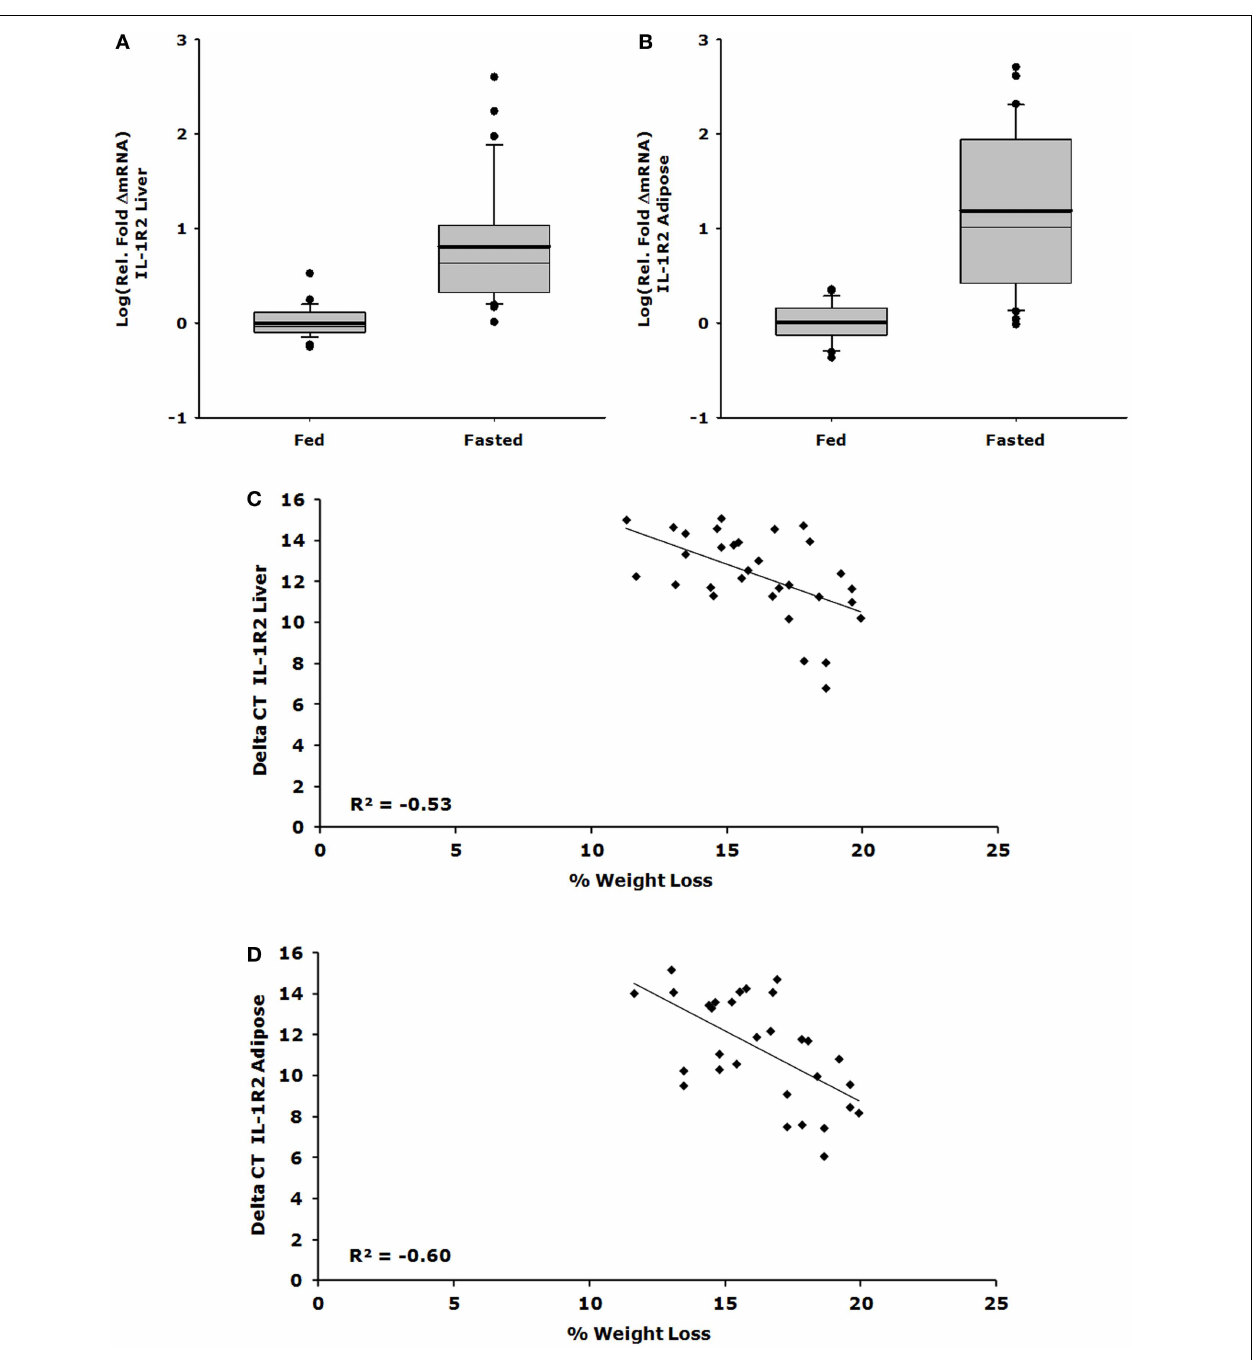
expressed as log [average relative fold change ( ∆ mRNA)] for fed ( n = 29) and fasted groups ( n = 31) * P < 0.001. (B) Adipose tissue IL-1R2 gene expression is summarized and expressed as log [average relative fold change ( ∆ mRNA)] for fed ( n = 29) and fasted groups ( n = 30) * P < 0.001. (C) Percent weight lost per mouse was correlated to delta CT value for IL-1R2 in the liver, significant correlation was observed P = 0.002, n = 31. (D) Percent weight lost per mouse was correlated to delta CT value for IL-1R2 in the adipose tissue, significant correlation was observed P < 0.001, n =